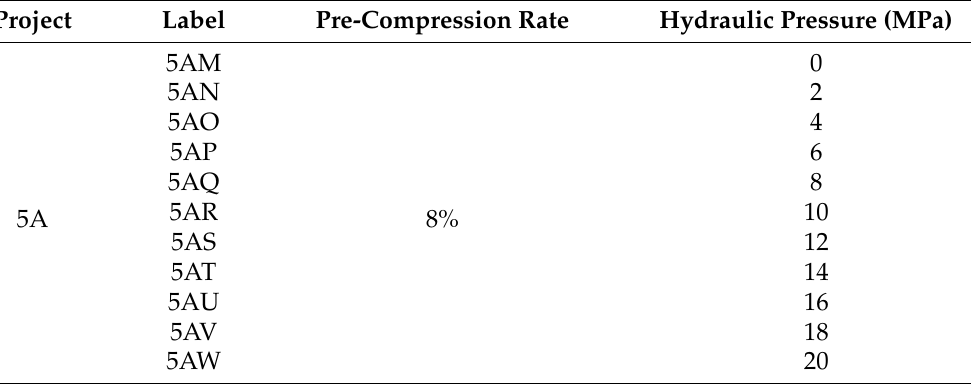
Table A4. Parameters and Labels of Hydraulic Pressure